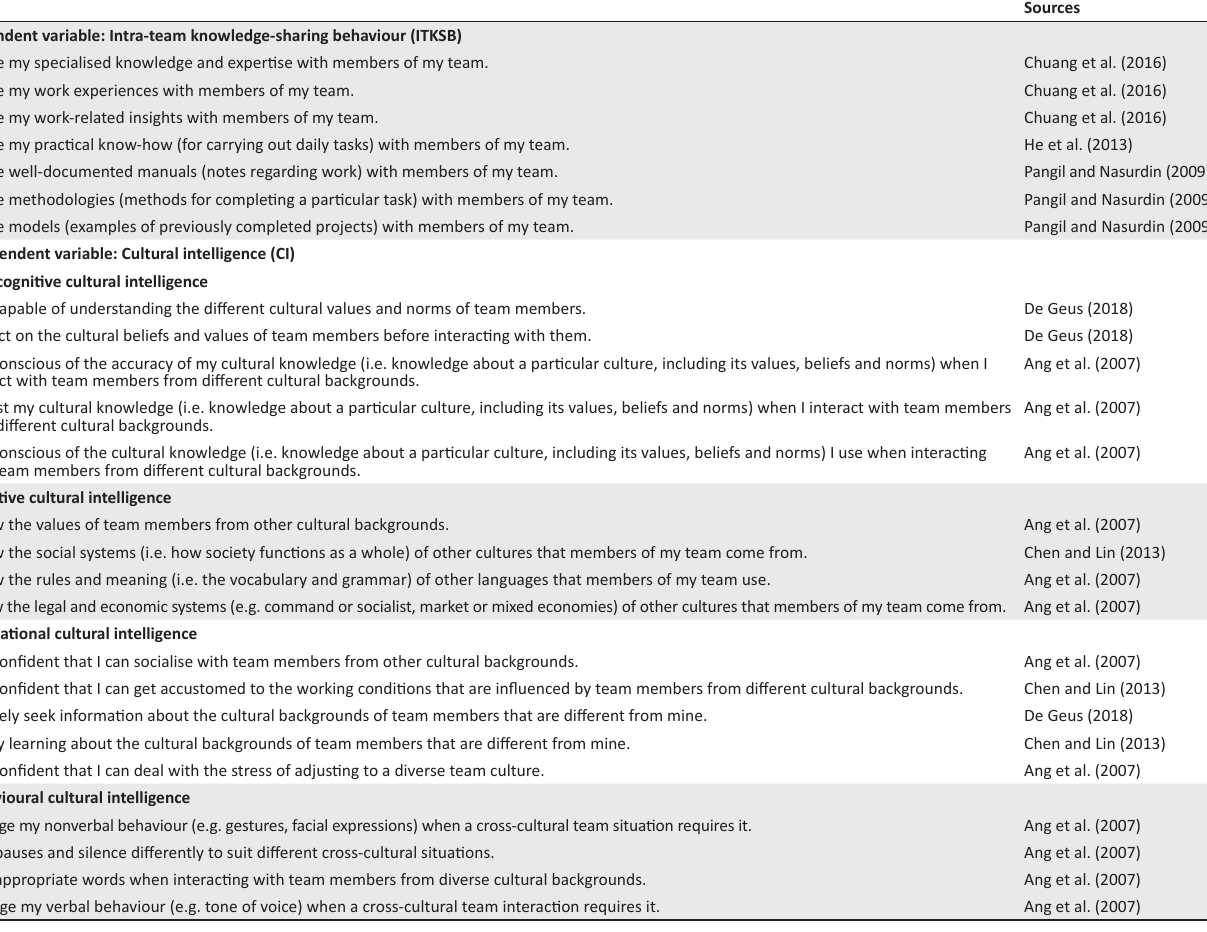
TABLE 1: Operationalisation of the dependent and independent variables.